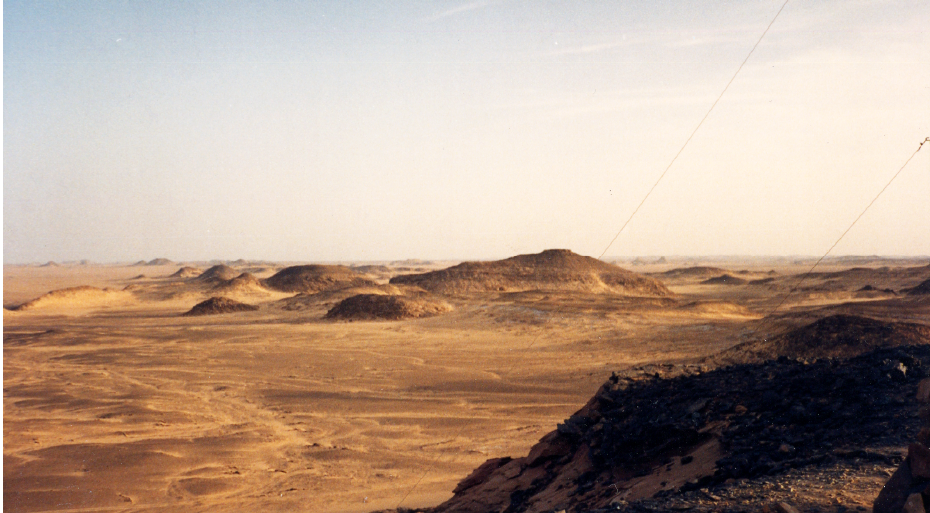
Figure 2. The Western Desert near Lake Nasser and the Toshka region (photo by the author).